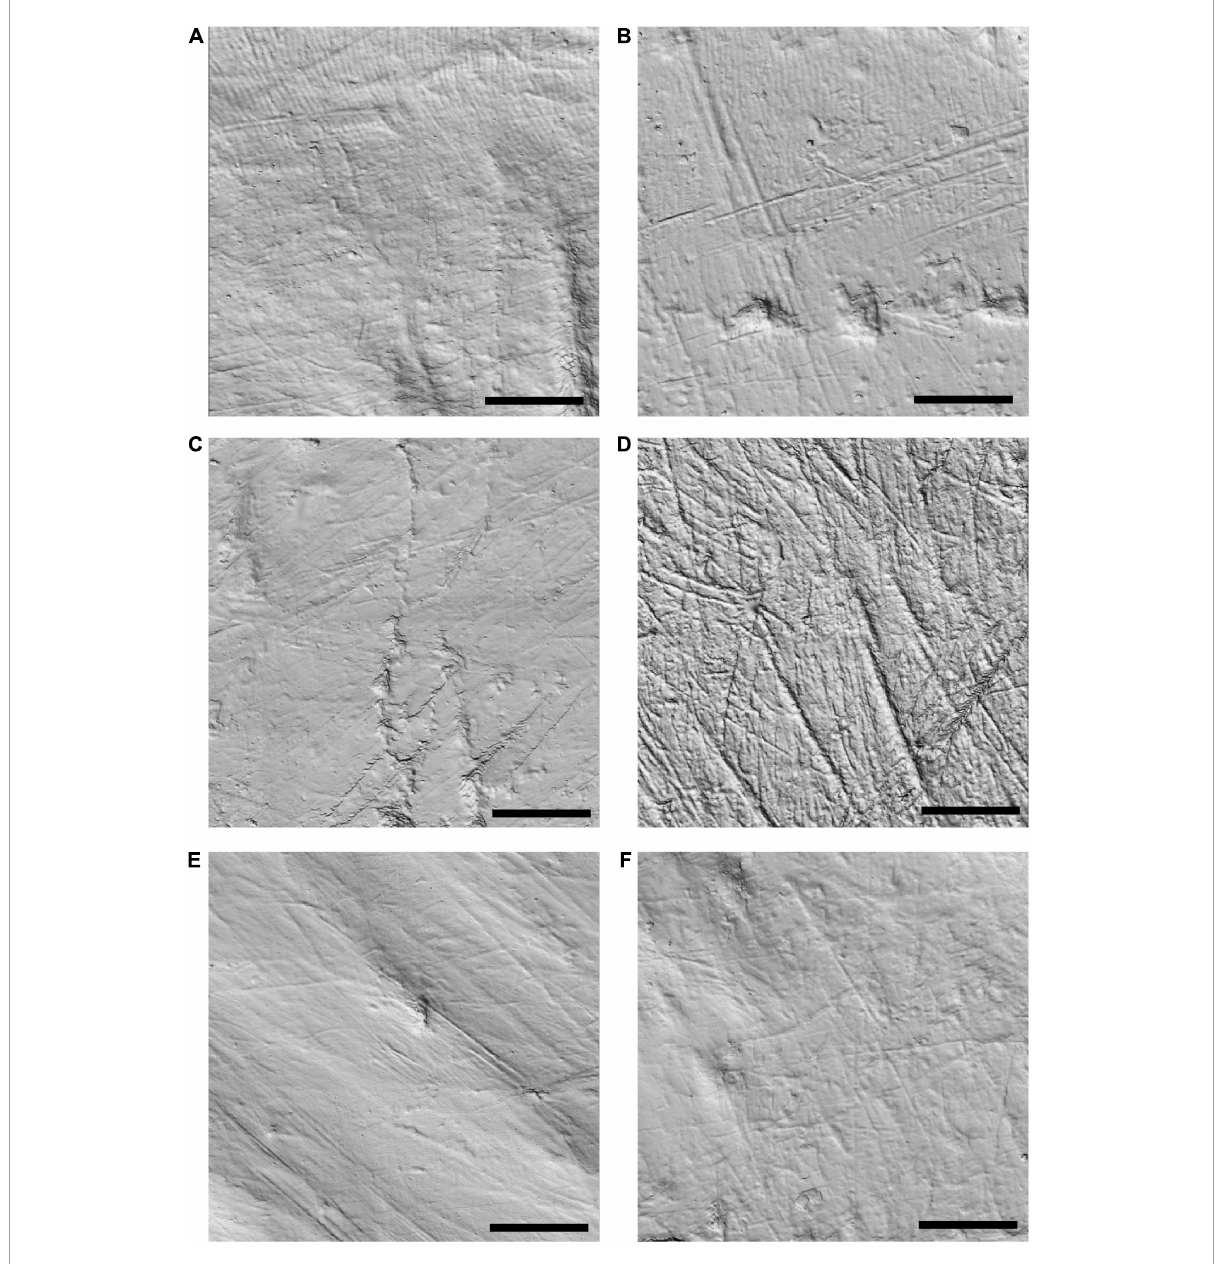
FIGURE3 Dental microwear textures from the second molars of (A) extant C. sumatraensis , (B) Pleistocene C. sumatraensis , (C) extant N. griseus , (D) Pleistocene N. griseus , (E) extant N. goral , and (F) Pleistocene N. goral . Scale bars = 50 µ